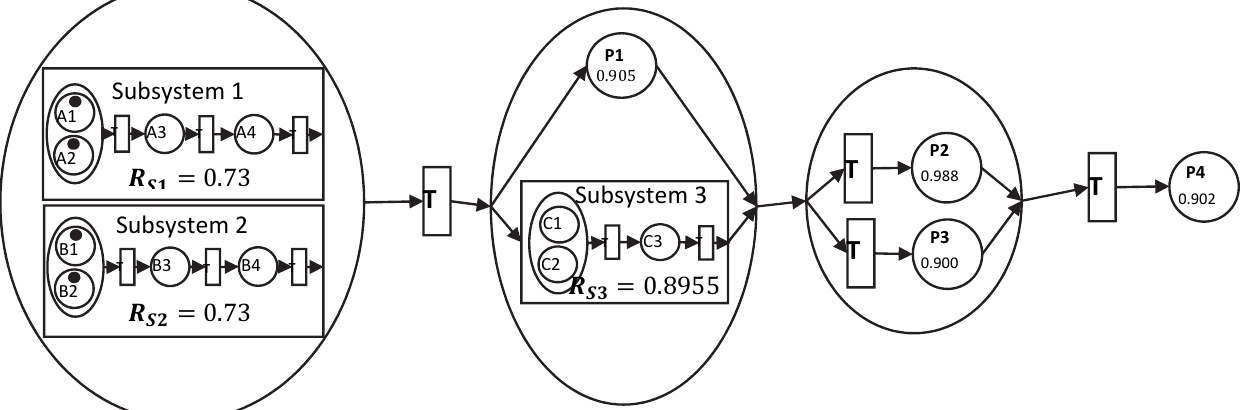
Fig. 4. Complete system diagram with reliability